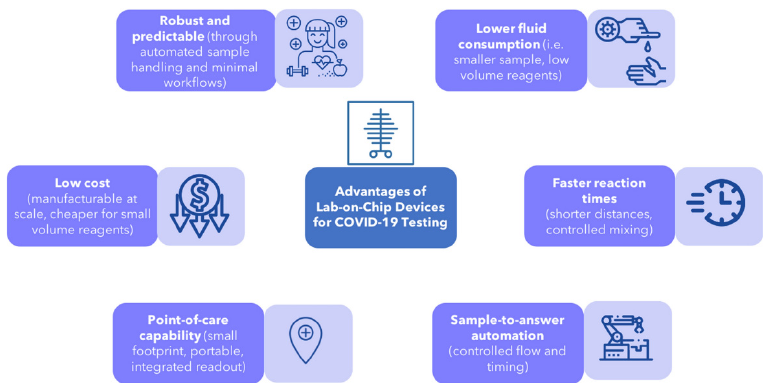
Figure 3. Schematic diagram depicts the advantages of lab-on-chip devices for COVID-19 testing. Reprinted with permission from Springer Nature [4], Copyright